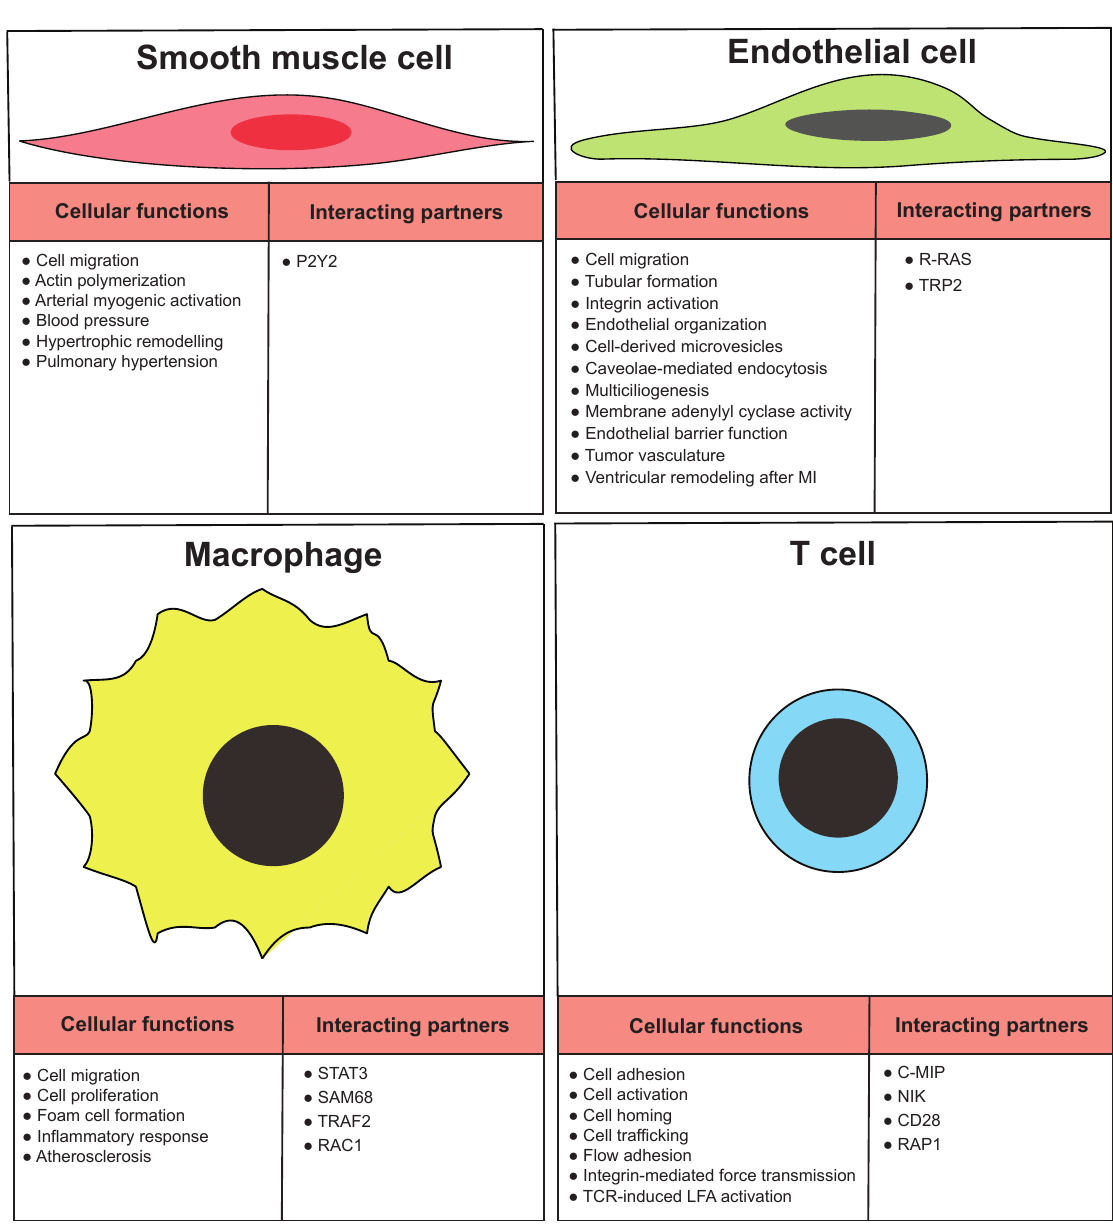
Figure 3. Functions of arterial wall cells regulated by FLNA. Cellular functions and some diseases are presented in relation to vascular smooth muscle cells, endothelial cells, macrophages and T cells. Furthermore, some interacting partners of FLNA in particular cell type are